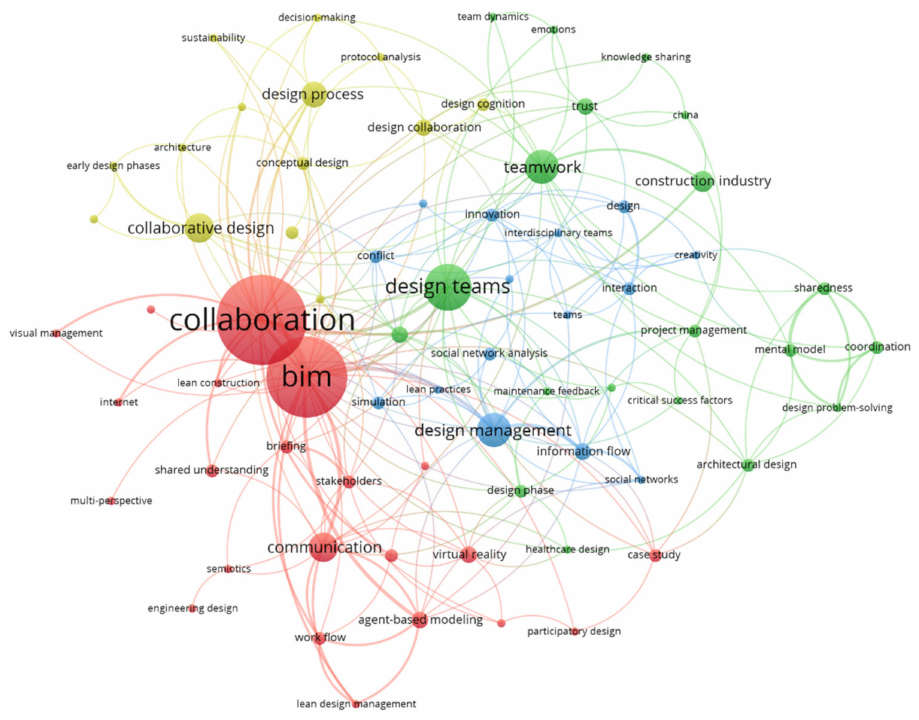
Figure 5. Co-occurrence map of